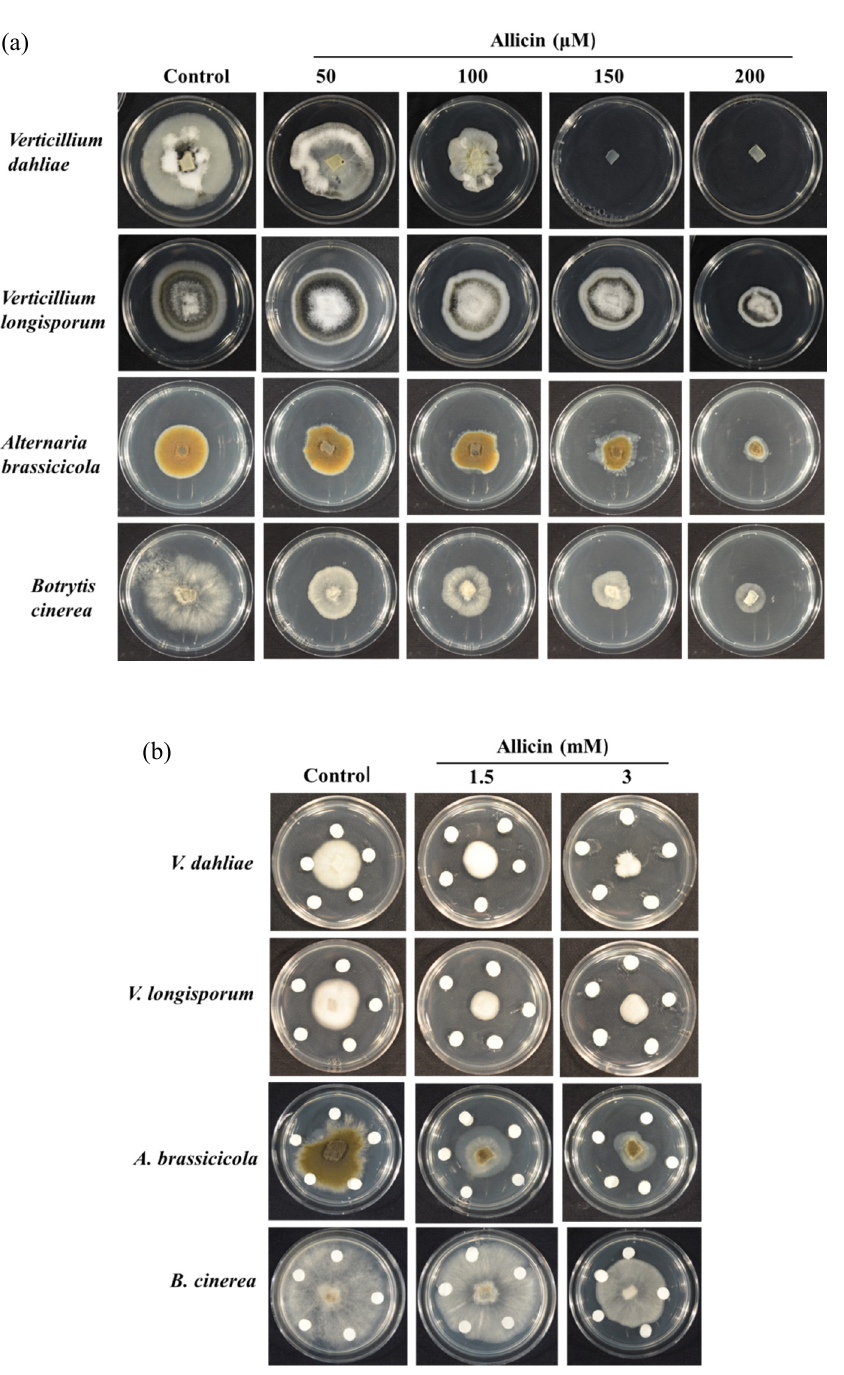
Figure 2. Zones of growth of fungi after treatment with allicin at different concentrations. The fungal growth zone is greater in respective control as compared to plates containing specific concentration of allicin. (a) Allicin was added to PDA to achieve final concentrations of 50, 100, 150 and 200 μ M. ( b ) The 20 μ L of 1.5 or 3 mM allicin was pipetted into each disc. The plates were then incubated at 22 °C for one week and photographed. In the control plate, the fungus grew normally from center towards the corners of the plate. Fungal growth was restricted in allicin treated plates. The concentration dependent growth inhibition was observed in case of test fungi.